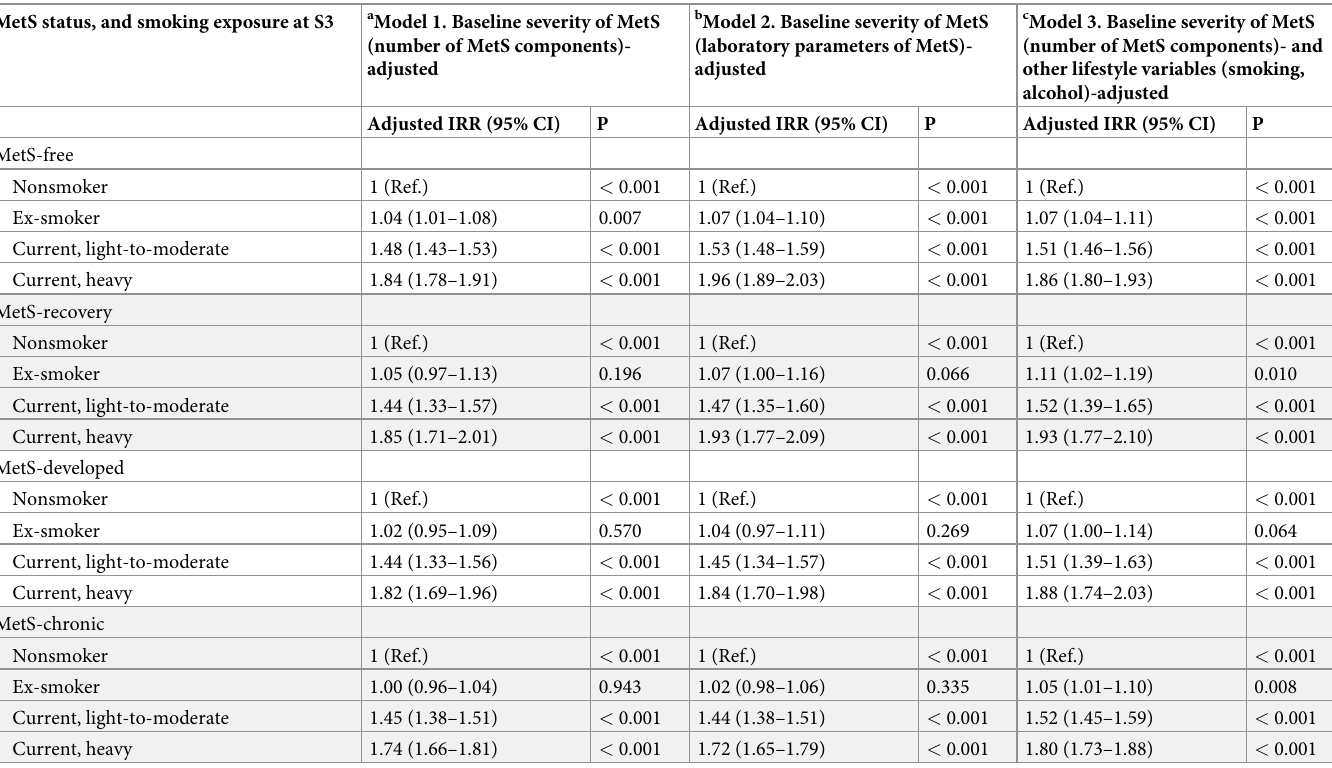
Table 4. Risk of major adverse cardiovascular events according to smoking status at the third health screening (S3) in each study